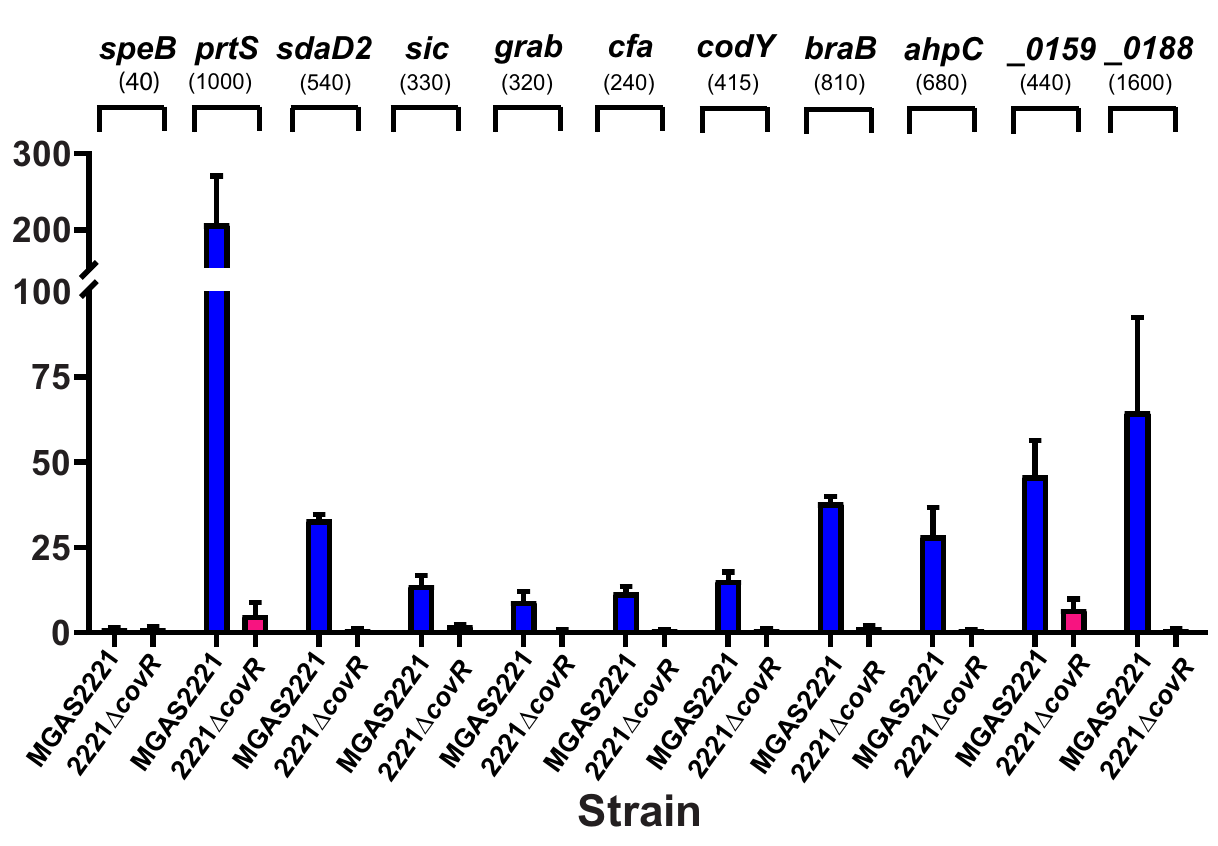
Fig 3. CovR directly regulates the vast majority of virulence factor encoding genes in the CovR regulon. Graphical representation of variation in gene transcript levels in 2221-CovR-D53A (no CovR~P) relative to wild type strain MGAS2221 using RNAseq data from [30]. Gene names or spy numbers (from the MGAS2221 genome) are provided for those genes with � 3-fold change in transcript levels indicated by dashed lines and are labeled in black (CovR binding detected in our ChIP-seq data) or red (no CovR binding detected), respectively. Note, that for repressed genes in particular, nearly all highly impacted genes have CovR binding sites.